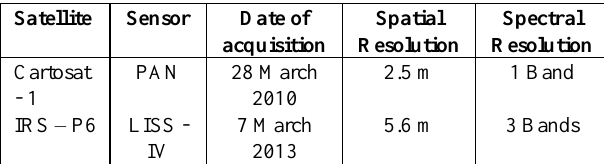
Table 1. Details of Remote Sensing data used